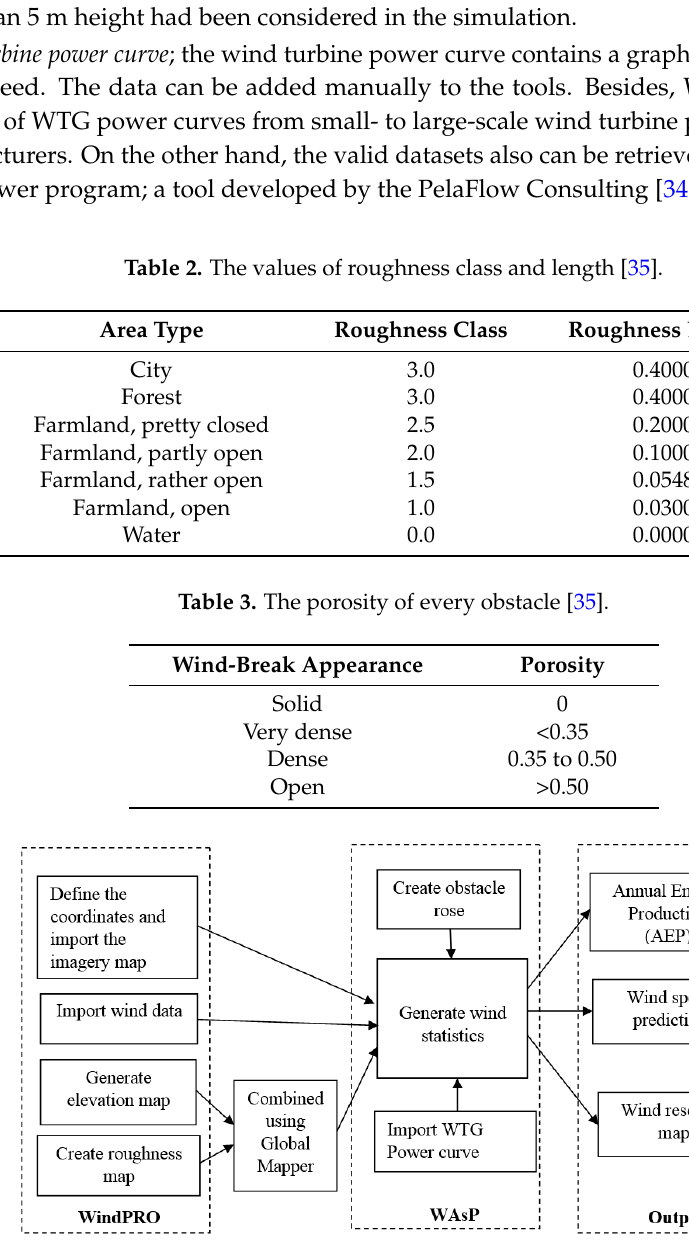
Figure 2. Methodology of the wind modelling using WAsP and WindPRO.